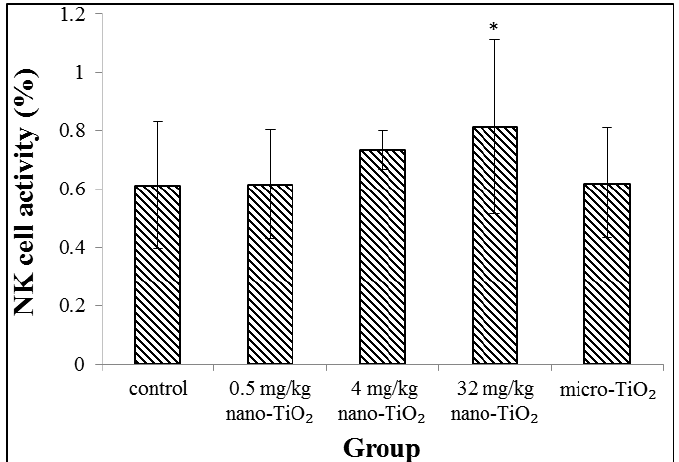
Figure 3. Natural killer (NK) cell activity in the spleen from rats exposed to nano-TiO 28 days by intratracheal instillation. * represents significantly different from control group ( p <